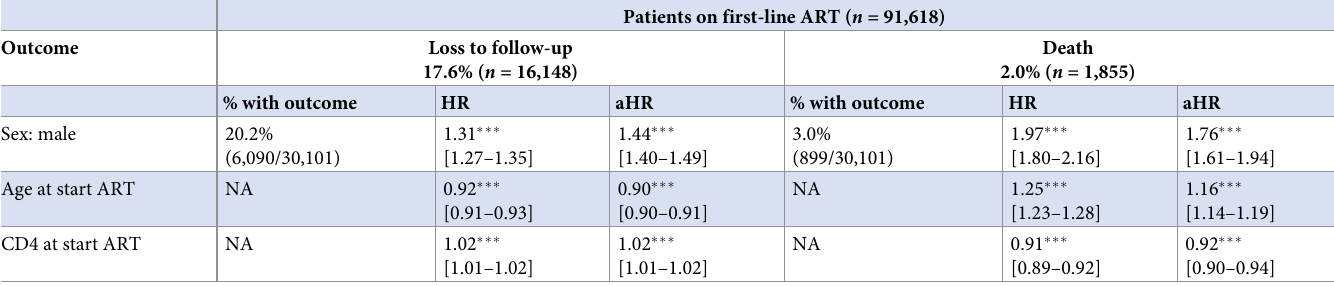
Table 3. Mixed-effects Cox proportional hazards analysis—Loss to follow-up and